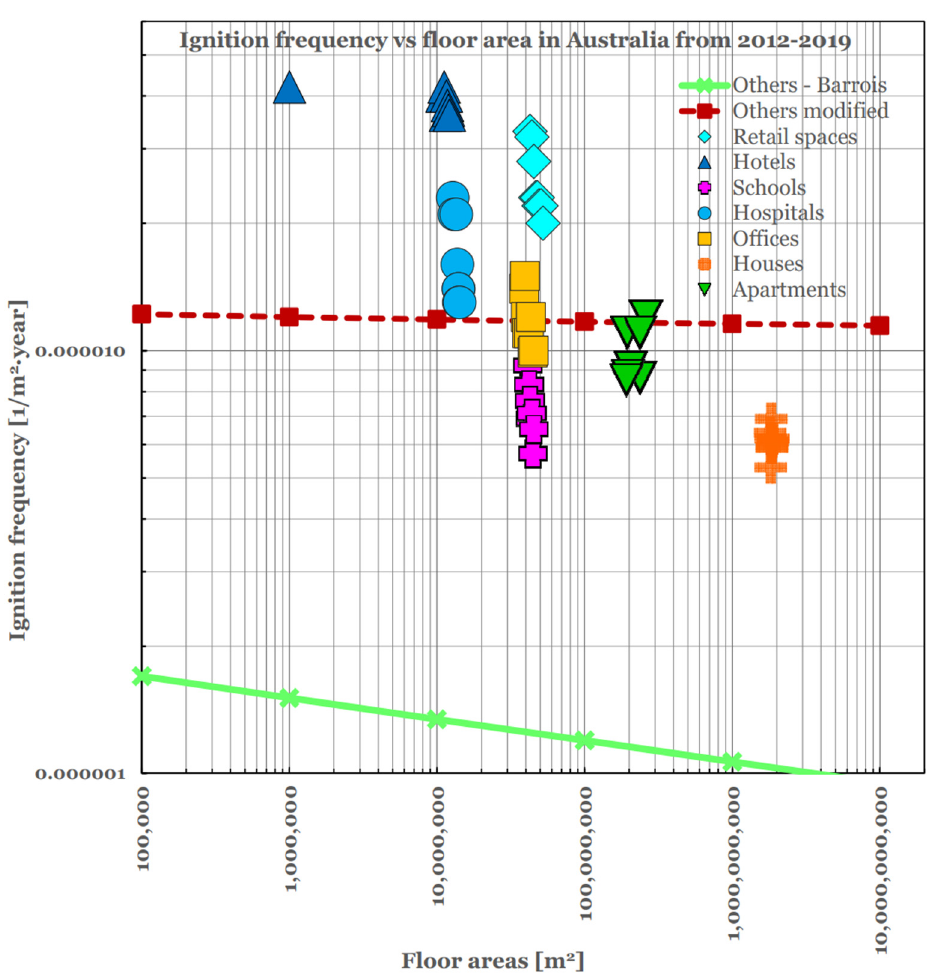
Figure 9. The average ignition frequency of different building classes as a function of floor areas in Australia between 2012 and 2019. (In Figure 9, only two Barrois curves are presented as the focus is on the ‘Others’ group of buildings).